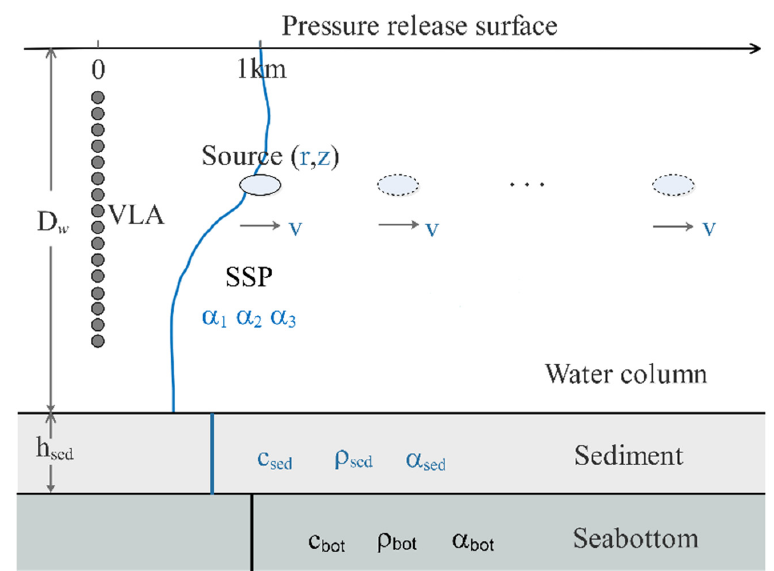
Figure 1. Environment model used for both two examples. Table 1. Environmental and simulation parameters for Example 1.